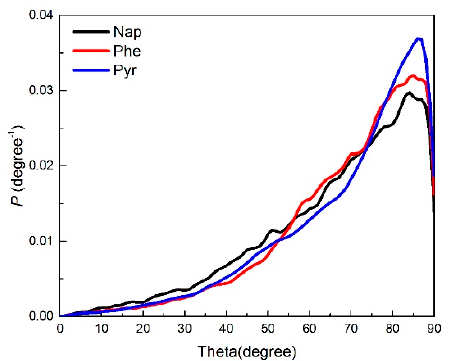
Figure 3. Angle distribution of Nap, Phe, and Pyr on the MCM-41 model. Key: black, Nap; red, Phe; blue, Pyr. Table 1. Order parameter (S) for the molecular direction of Nap, Phe, and Pyr.